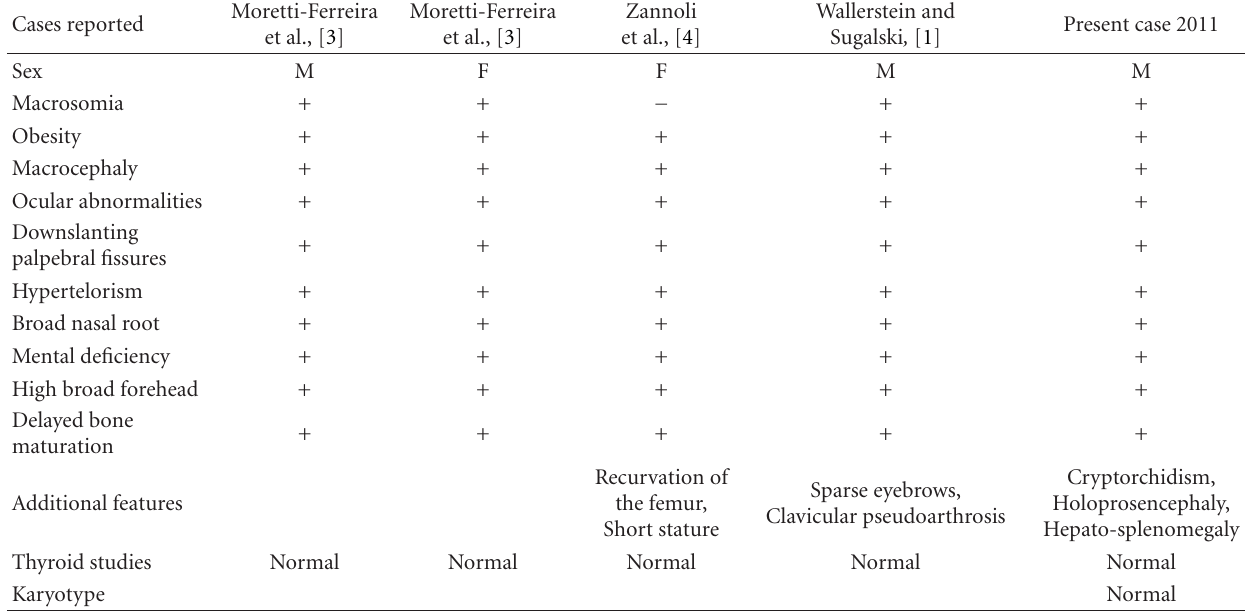
Table 1: Comparison of the cases reported in literature